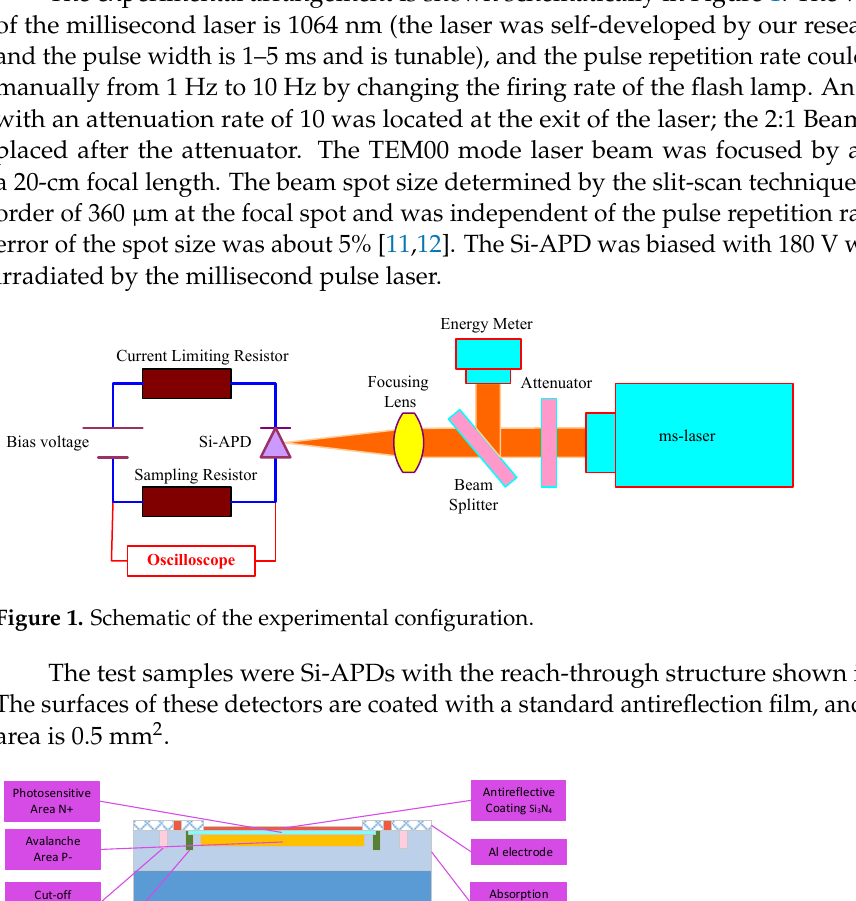
is 50 K Ω , the current limiting resistor is 1 M Ω and the working voltage is 180 V. The sam-